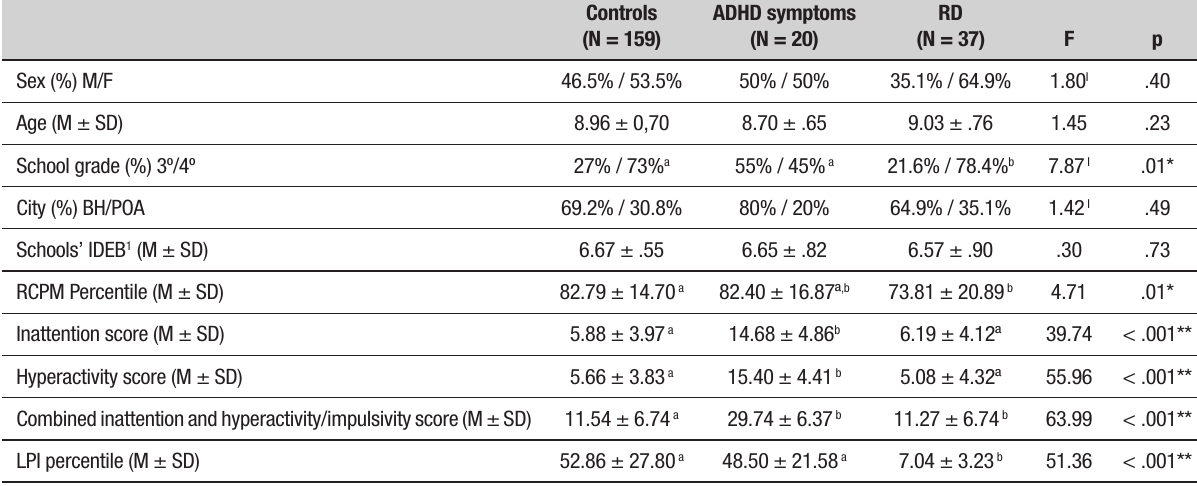
Table 1. Characteristics of the three groups according to sociodemographic variables, percentile in the RCPM, MTA-SNAP-IV questionnaire score, and LPI percentile (N =